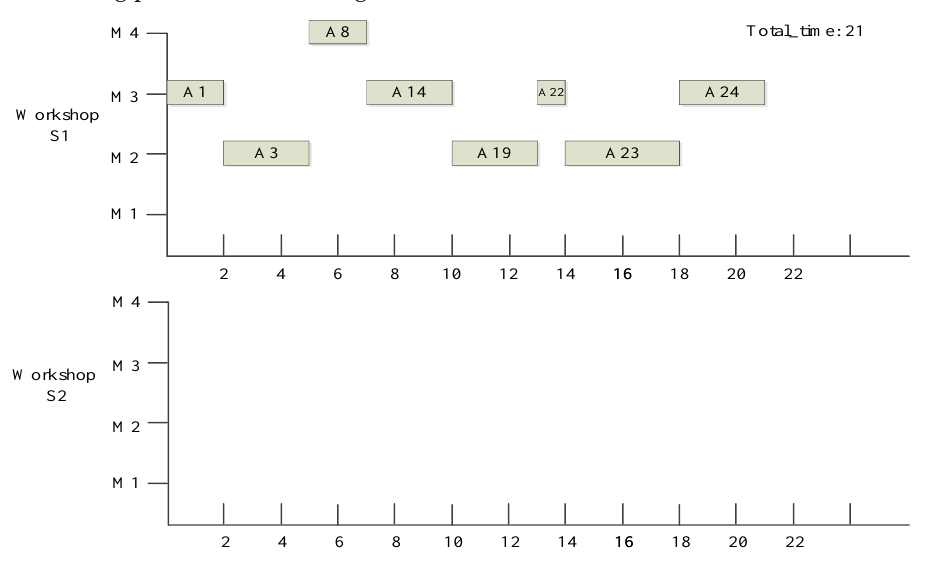
Figure 3. The initial scheduling scheme is formed by scheduling product A.